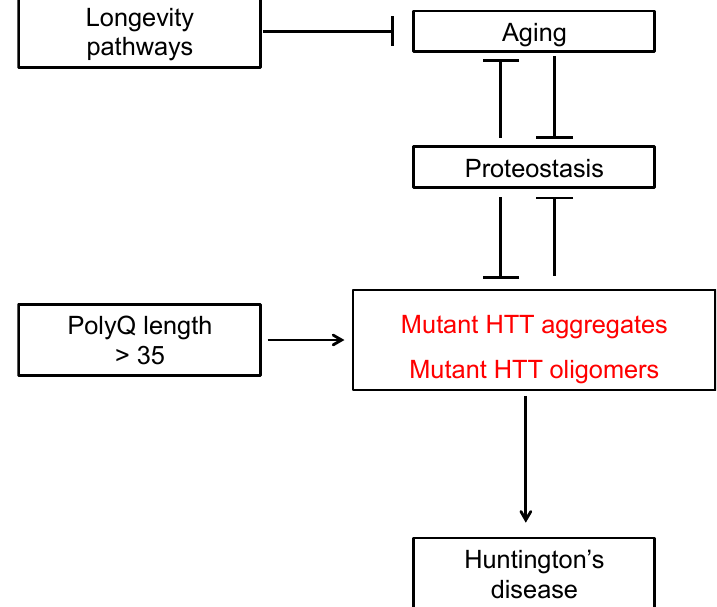
Figure 1. Huntington’s disease (HD) is caused by mutations in the Huntingtin gene ( HTT ) that expand the polyQ stretch of HTT protein, resulting in its aggregation and proteotoxicity. In individuals affected by HD, HTT contains >35 polyQ repeats. The length of the polyQ stretch correlates with the accumulation of toxic polyQ-expanded HTT aggregates and oligomers. The protein homeostasis (proteostasis) network controls the folding and clearance of mutant HTT, reducing its proteotoxicity. However, the accumulation of polyQ-expanded HTT aggregates and oligomers can result in a collapse of proteostasis, a feature that contributes to the neurodegeneration phenotype. With age, organisms lose the ability to maintain the proteostasis network; a process that could explain the late onset of HD. Conversely, mechanisms that extend longevity sustain proteostasis with age, reducing the accumulation of toxic mutant HTT aggregates and oligomers.